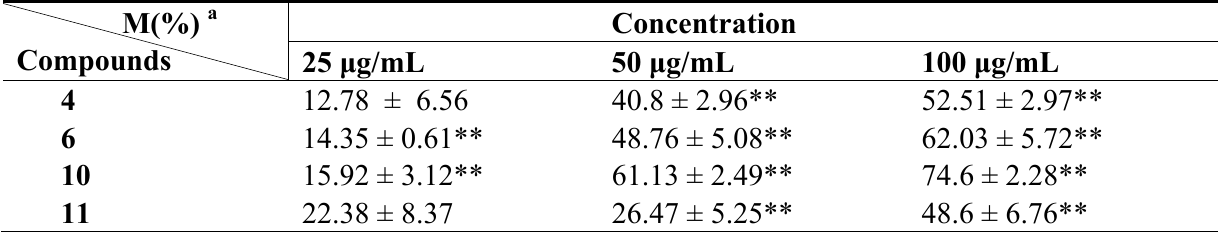
Table 3. Inhibitory effect of compounds 4, 6, 10, 11 on the proliferation of A549 lung cancer cells.